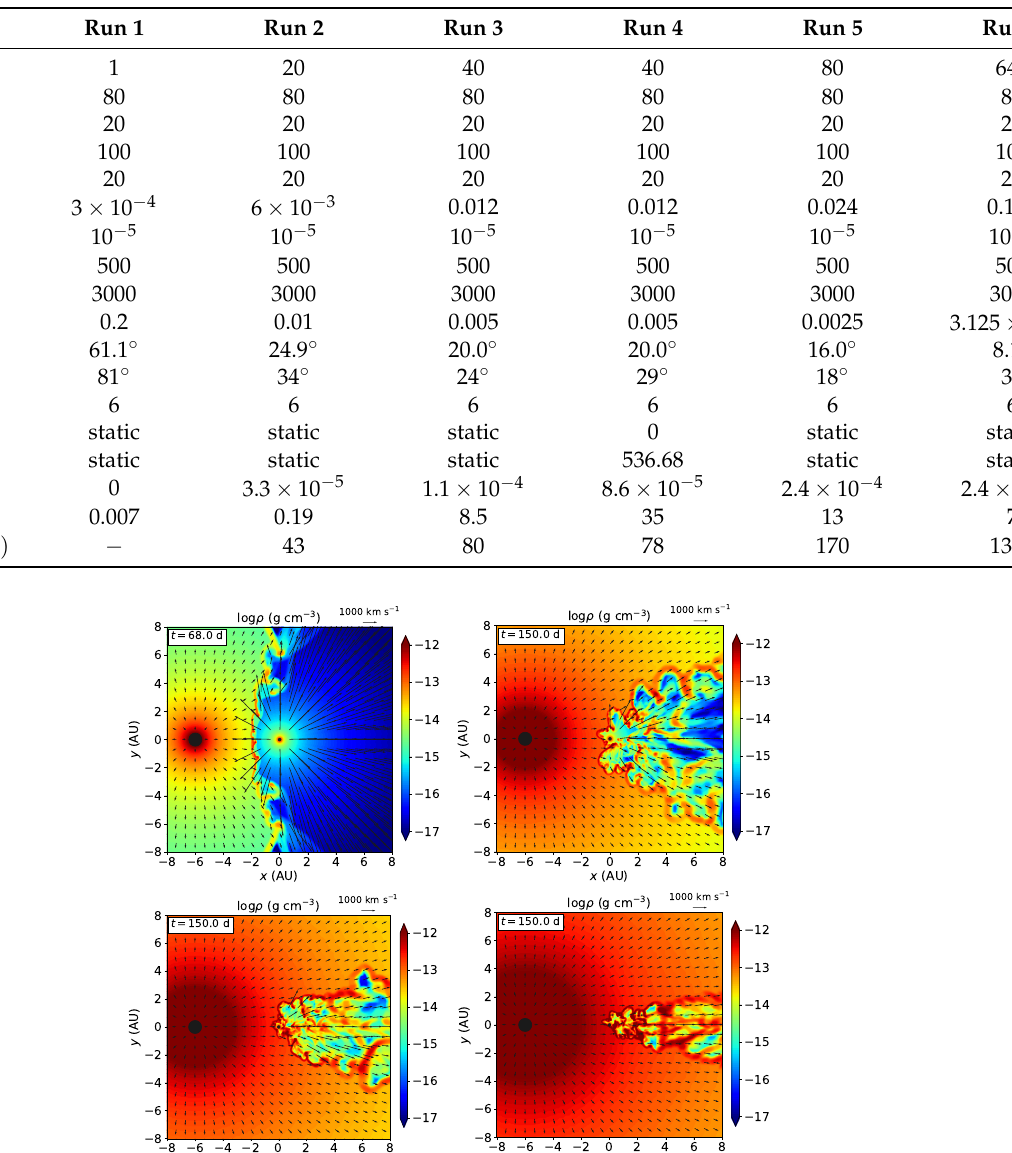
Table 1. Summary of simulations and results.